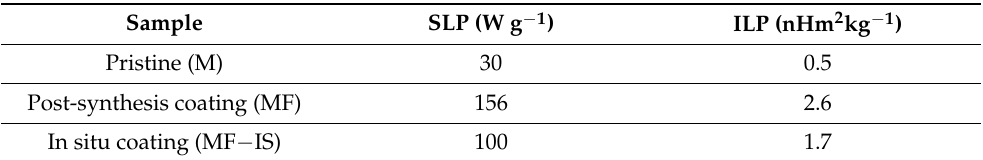
Table 3. Hyperthermia values obtained for all the samples. The SLP measurements were carried out using an AC field amplitude of 14.7 kA m − 1 at 276